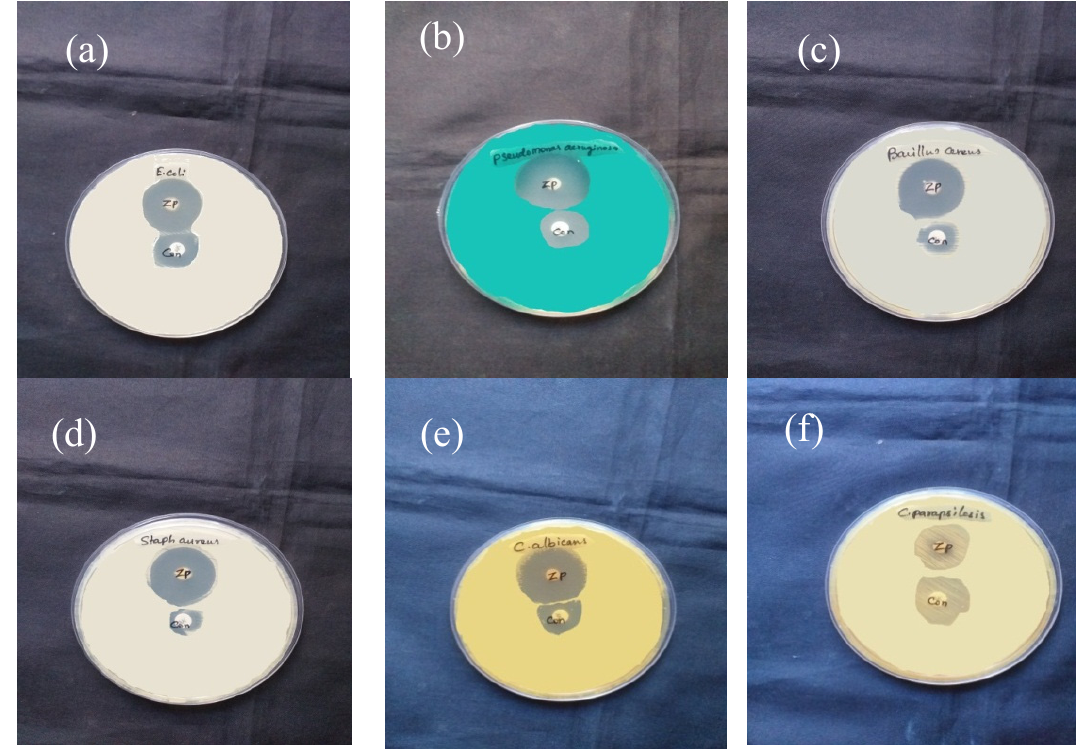
Fig. 10. Anti-bacterial and Anti-fungal effect of pure ZrO